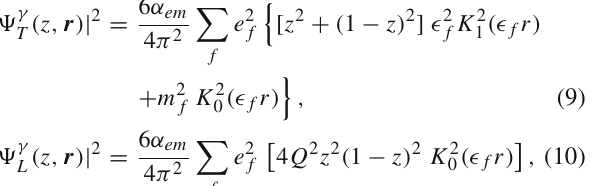
= 0 , Q 2 = 0 ) . Such 1 2